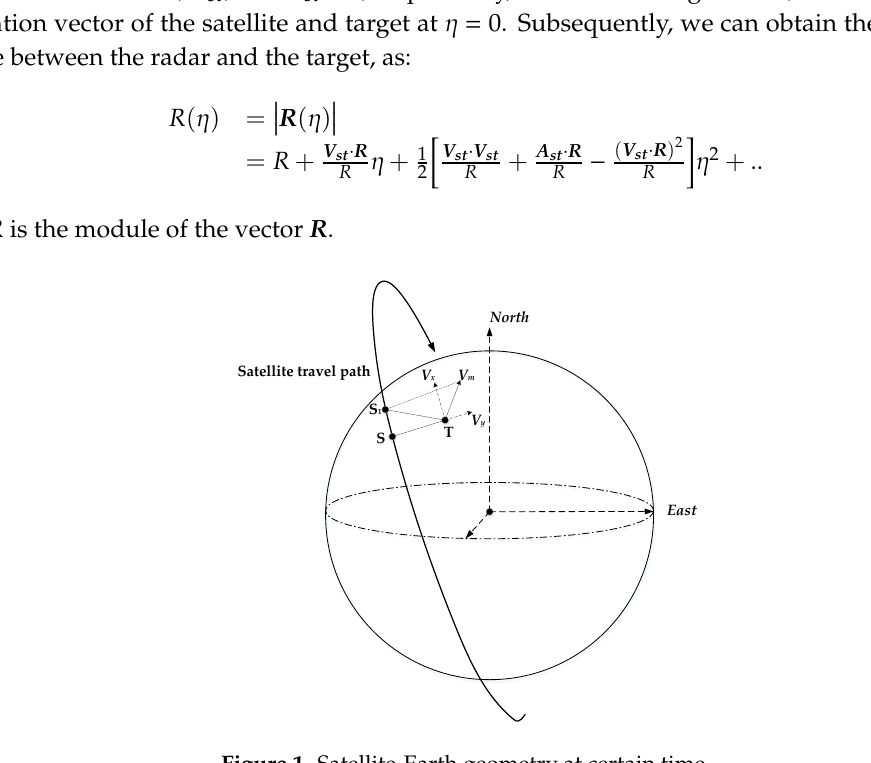
Figure 1. Satellite-Earth geometry at certain time.